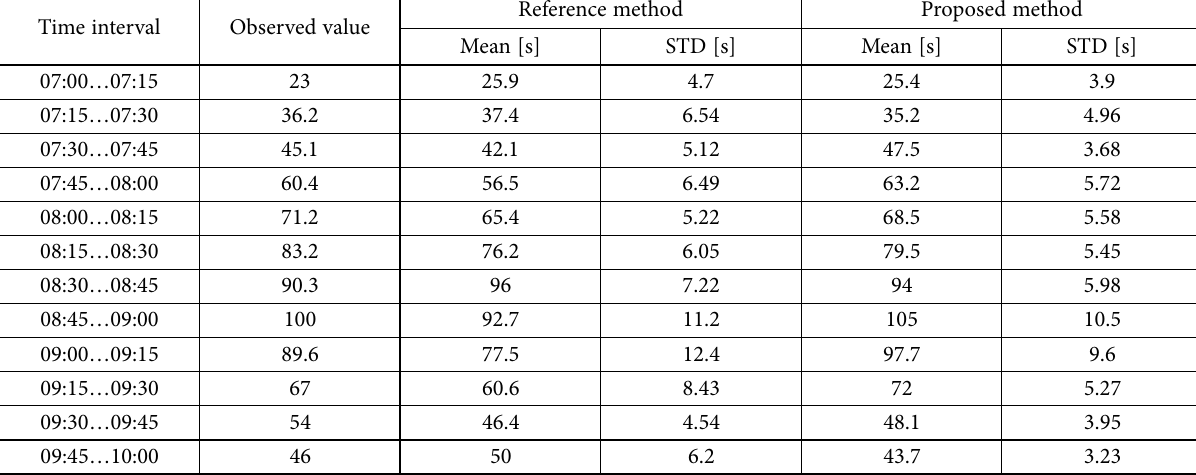
Table 2. Statistical results of control delay values from low-frequency sample point